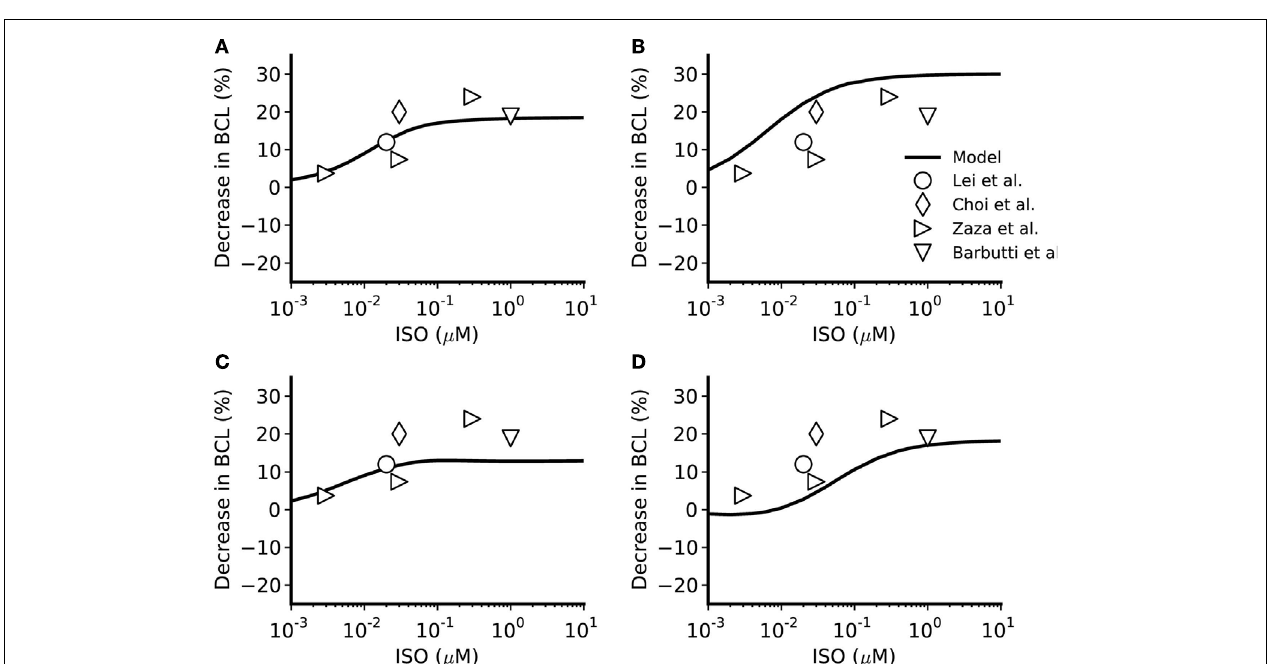
model in which effects of ISO are incorporated for all of I CaL , I f , I Kr , I Ks , I st , and Ca 2 + transient. Open circles: experimental data of Lei et al. (2000) from rabbit SAN cells. Open right-facing triangle: data of Zaza et al. (1996) from rabbit SAN cells. Open diamonds: data of Choi et al. (1999) from rabbit SAN cells. Open inverted triangles: data of Barbuti et al. (2007) from rabbit SAN cells.